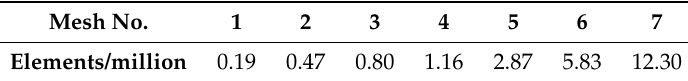
Table 3. Grids in the grid independence